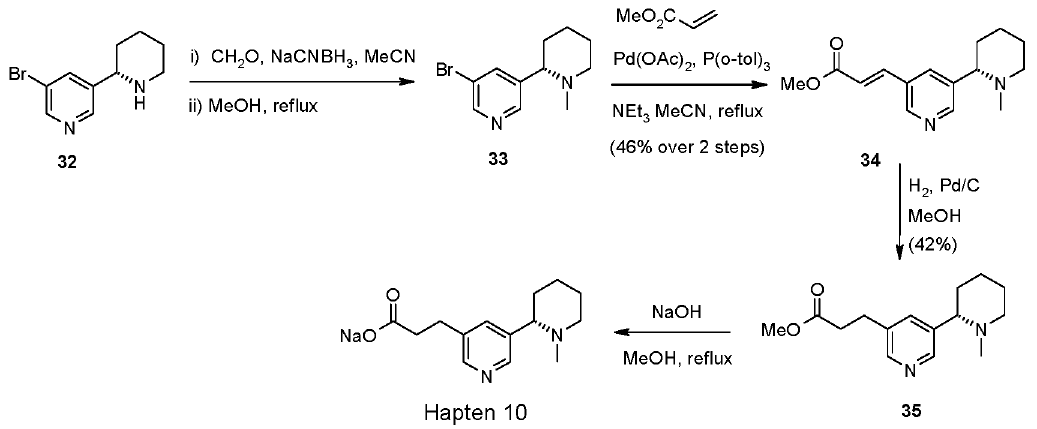
Figure 6. Synthesis of Hapten